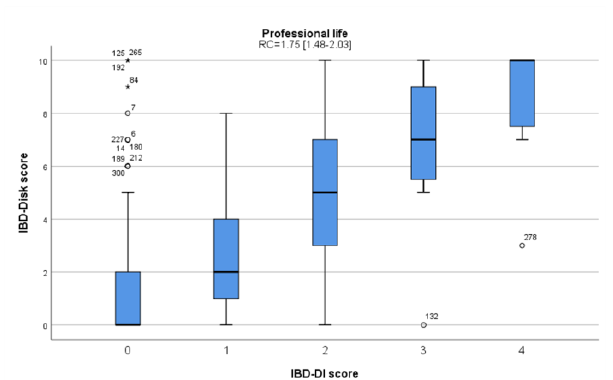
Figure 2. Reliability of the IBD-Disk compared to the IBD-DI per item at baseline ( n = 300).